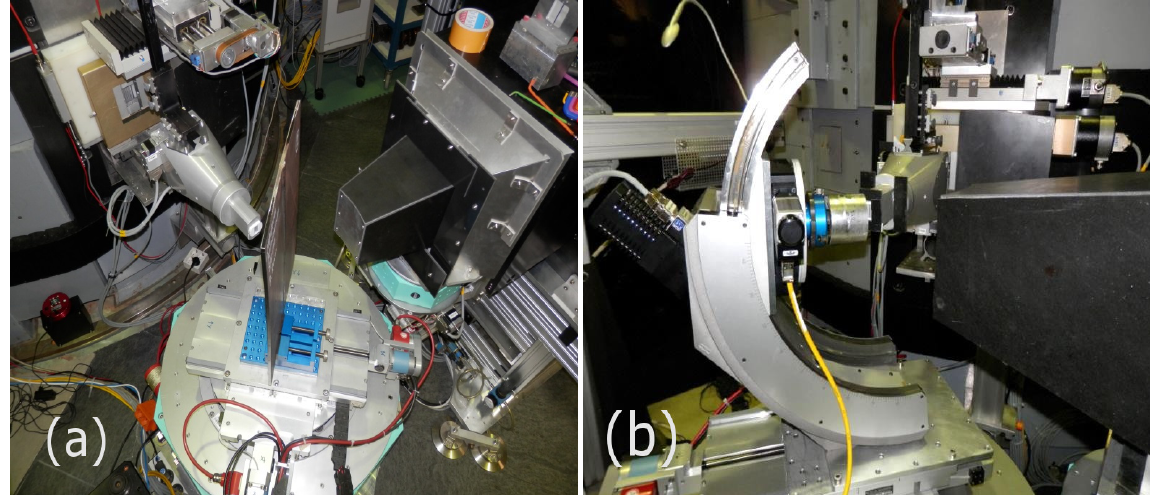
Figure 2: (a) Photograph of E3 with x-y-z table on top of the diffractometer circles for the positioning of a large 40×50 cm 2 weld plate. On the left: the motorized primary slit. On the right: the detector housing with an oscillating radial collimator in front of it. (b) Application of the goniometer table as a tilt stage in order to access three orthogonal sample orientations for RSA.